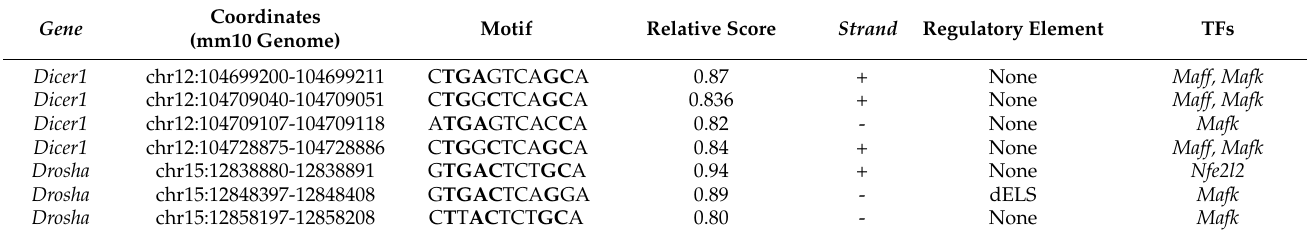
Table 4. Table showing the putative ARE sequences identified in the mouse genome with a relative score over 80%. Columns and content follow the same format as Table